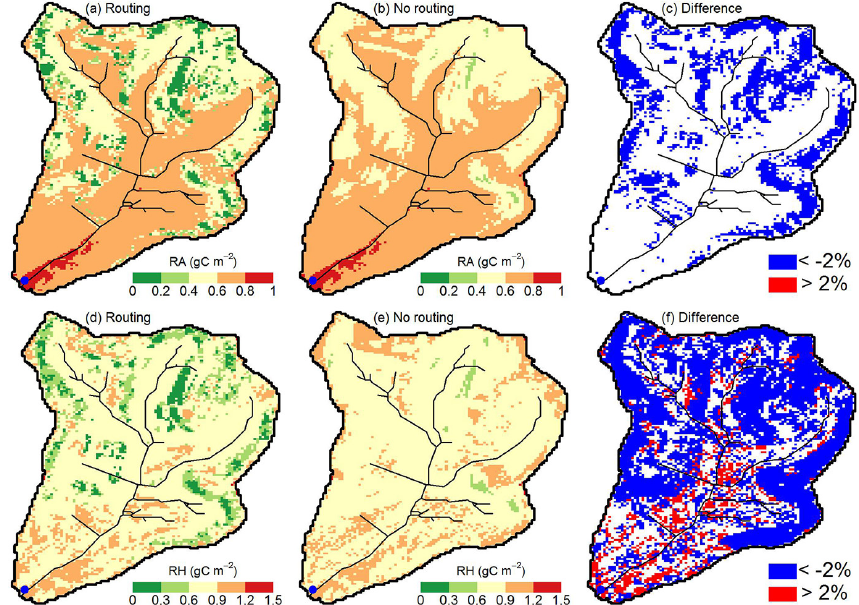
Fig. 6. Comparison of simulated monthly average daily soil autotrophic (RA) and heterotrophic respiration (RH) in July 1994 between the two simulations: (a) and (d) considering water routing while (b) and (e) ignoring water routing. (c) and (f) show percentage differences between the two simulations divided by results from the simulation considering water routing. The white areas show no significant differences.